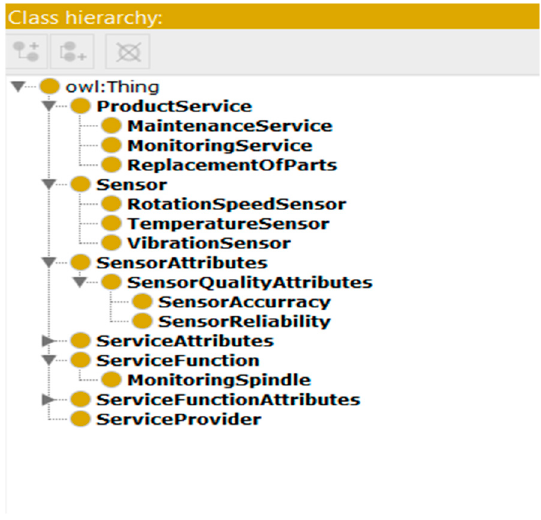
Figure 7. Examples of the classes and sub-classes included in the product-service ontology.